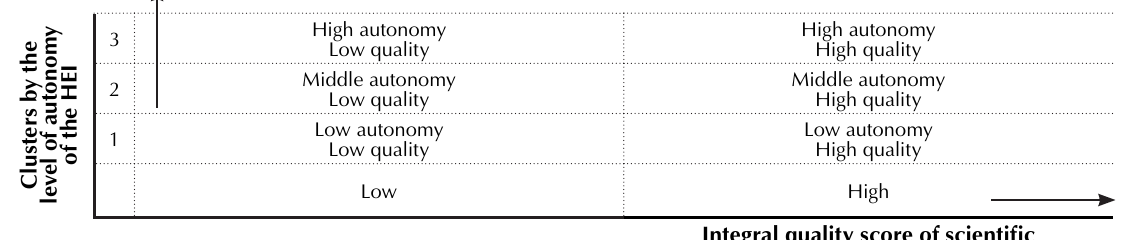
Figure 3. Matrix of recognition of the situation in relation to the autonomy of the